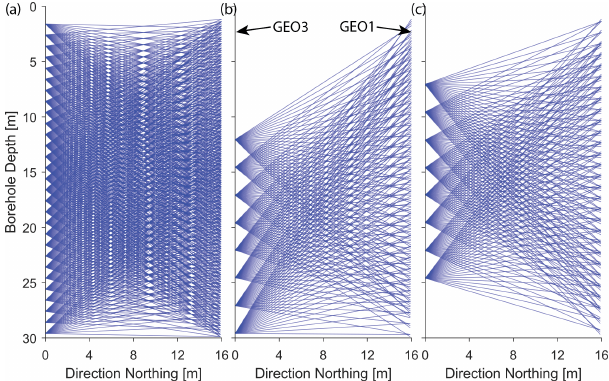
Figure 4. Ray coverage for the transmission data sets. Only every fifth ray is plotted. Panel (a) shows the comprehensive baseline data set; (b) and (c) show the two subsets for the time-lapse transmission